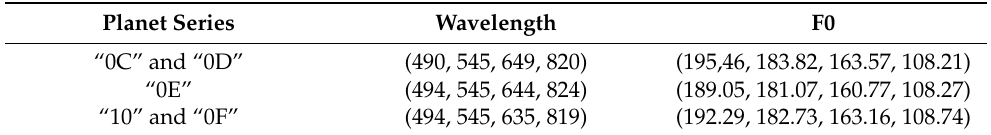
Table 3. PlanetScope series identifiers, center wavelengths based on relative spectral response functions, and F0 constants for each wavelength.